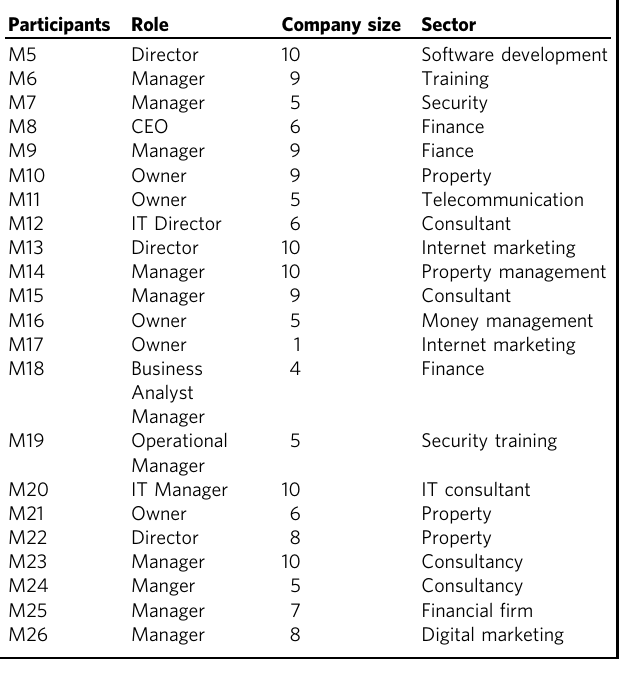
Table 2 Company pro fi le and the main study participants ’ pro fi le.